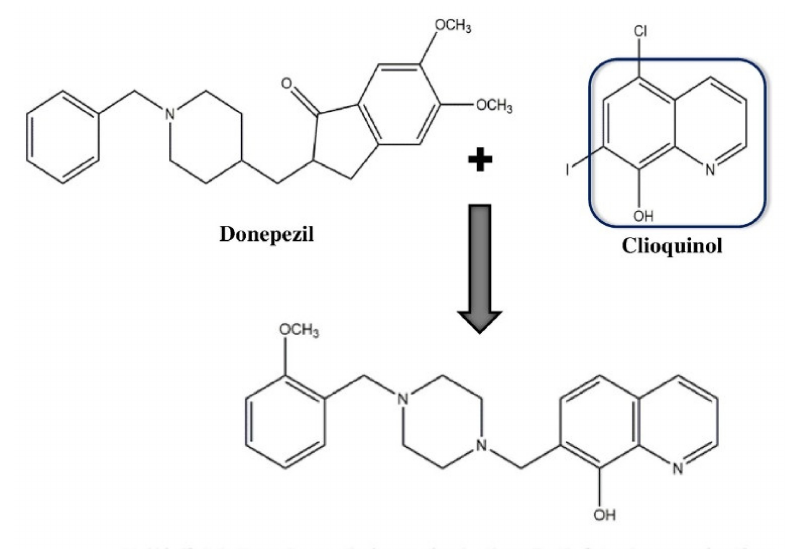
Figure 3. Chemical structure of one heterodimer of donepezil and clioquinol.